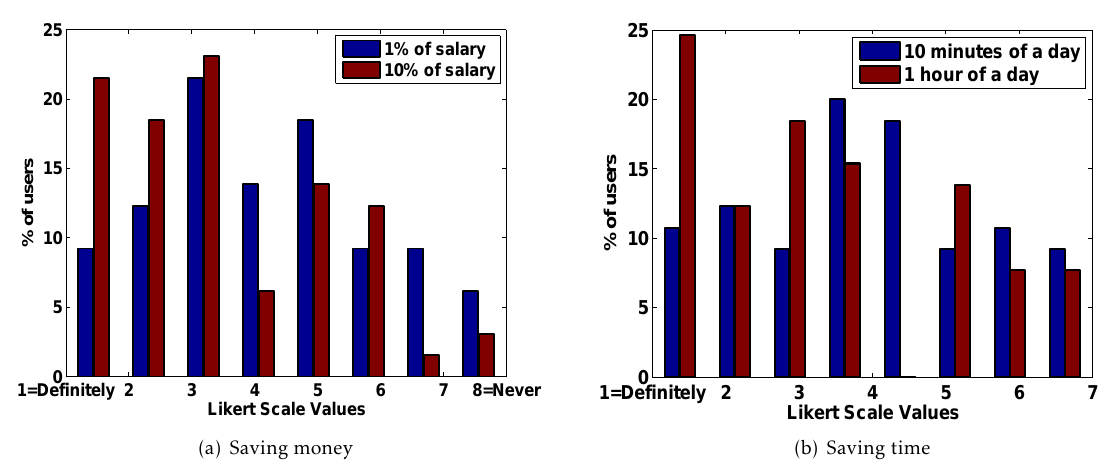
Figure 4. Responses to Benefits to users questions (best viewed in